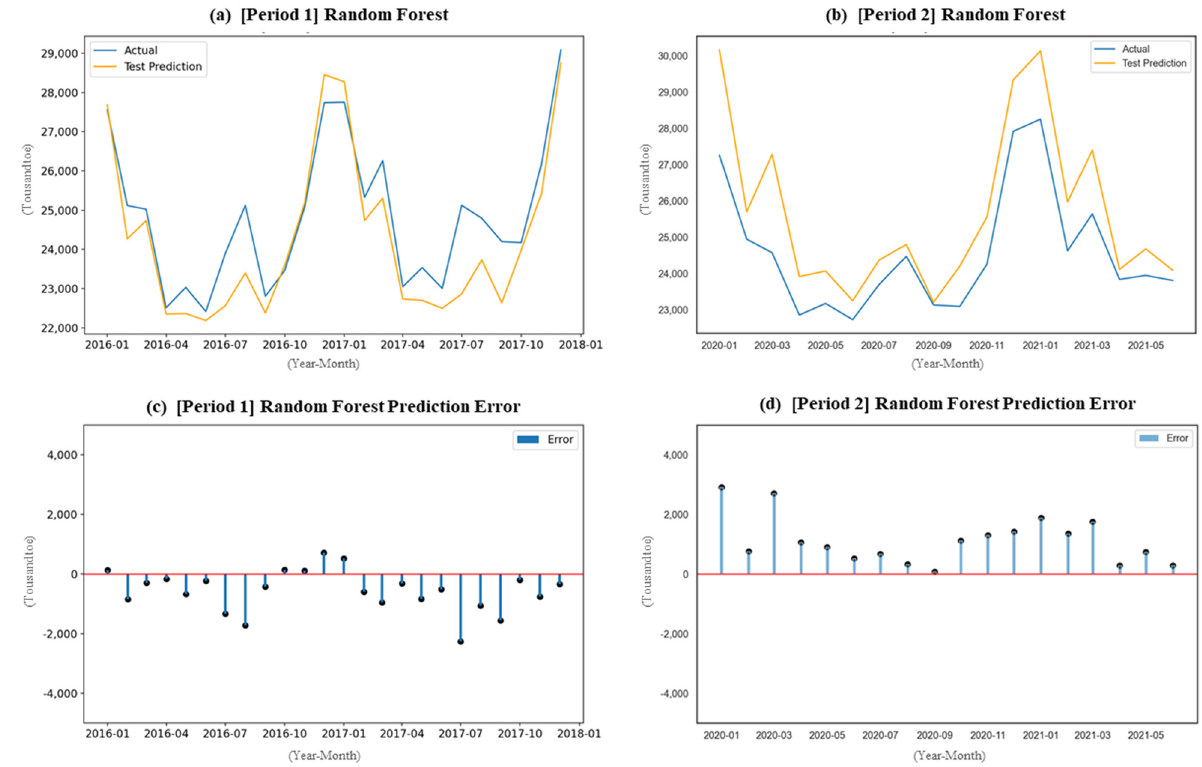
Energies 2022 , 15 , x FOR PEER REVIEW 18 of 22 Figure 9. Random forest model comparison by period with prediction error. Figure 9. Random forest model comparison by period with prediction error.